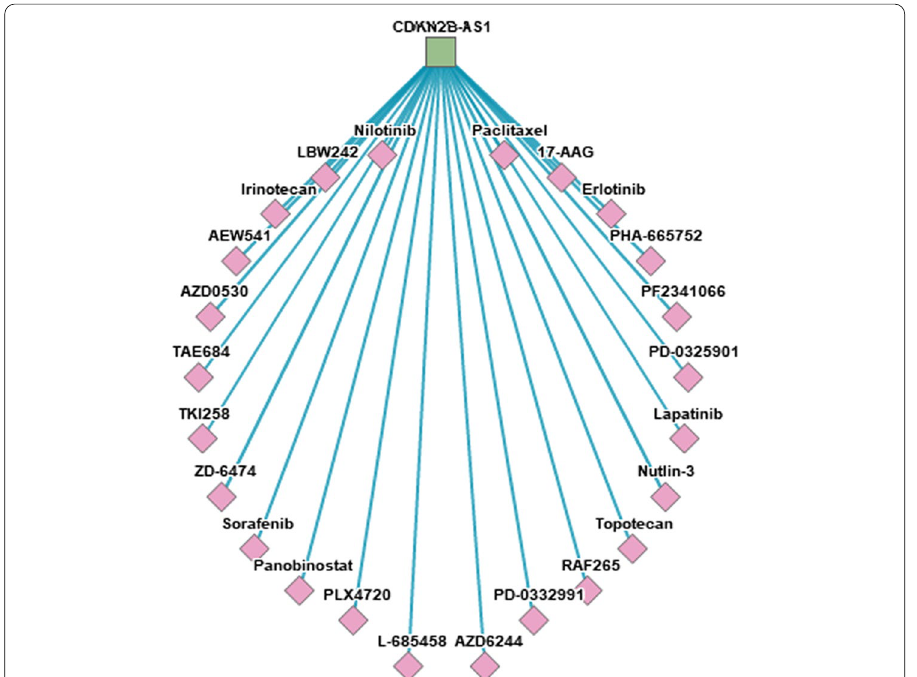
Fig. 8 Drug-LncRNA Network. The top 30 drug-lncRNA pairs were used to build the network. The square and the diamond represent lncRNA and drug, respectively (Data source: LncMap (http:// bio- bigda ta. hrbmu. edu. cn/ LncMAP/ drug_ lnc.